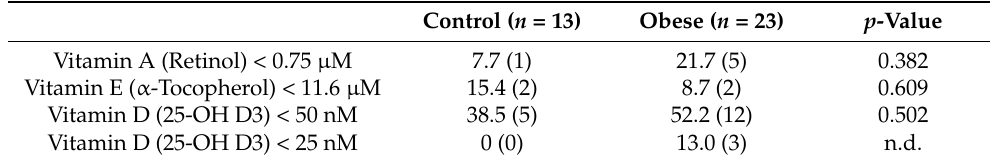
Table 7. Prevalence of vitamin deficiency by study